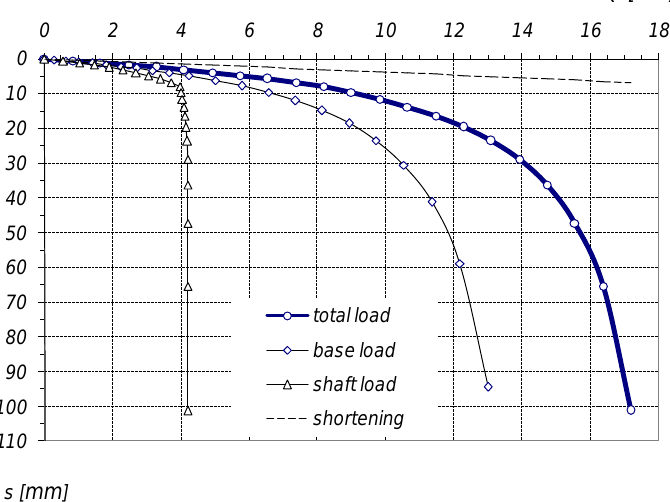
Figure 3. Example of settlement curves for a single pile.